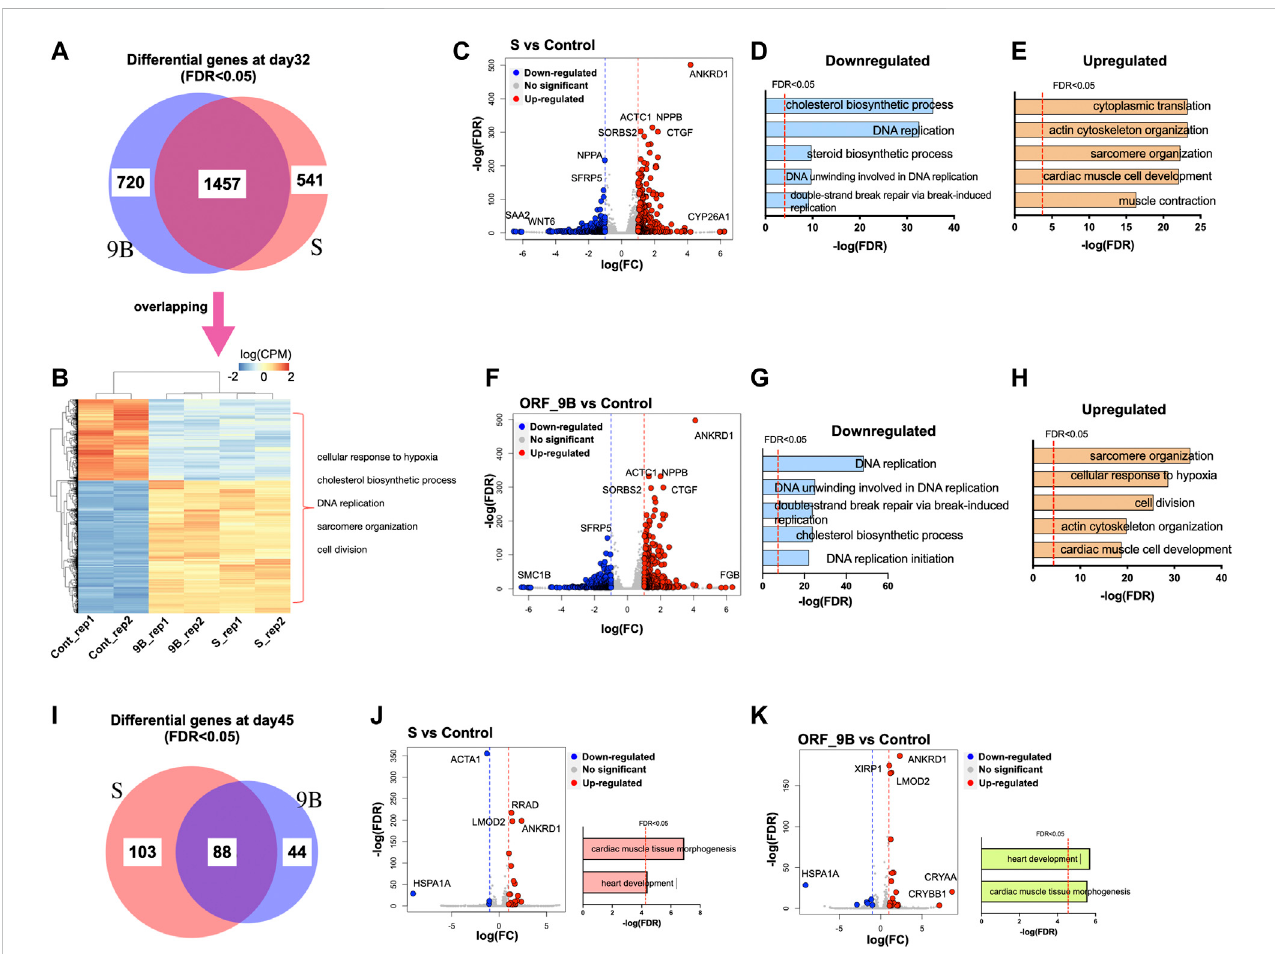
FIGURE 4 Transcriptomic analysis of CMs after overexpression of SARS-CoV-2 subunits. (A) The Venn diagram exhibits the statistically differential genes in CMs afteroverexpressionORF-9BorS(FDR < 0.05)dayday32. (B) TheheatmapexhibitstheexpressionofoverlappingdifferentiallyexpressedgenesintheORF-9B andSgroup,comparedtothatincontrol.Eachgrouphadbiologicalreplicates.TherepresentativeenrichedGOterms(FDR < 0.05)areshownontherightside. (C) ThescatterplotshowsdysregulatedgenesintheSgroupcomparedtothatincontrol(FDR < 0.05withlog[FC]largerthan1).Red,upregulatedgenes; blue, down-regulated genes. (D, E) The top enriched GO terms (FDR < 0.05) of the downregulated genes (D) and the upregulated genes (E) in the S group. (F) The scatter plot shows dysregulated genes in the ORF-9B group compared to that in control (FDR < 0.05 with log[FC] larger than 1). Red, upregulated genes; blue,down-regulatedgenes. (G,H) ThetopenrichedGOterms(FDR < 0.05)ofthedownregulatedgenes (G) andupregulatedgenes (H) intheORF-9Bgroup. (I) The Venn diagram exhibits the statistically differential genes in CMs after overexpression ORF-9B or S (FDR < 0.05) day day45. (J – K) Left, the scatter plot shows dysregulated genes in the S group (J) and ORF-9B group (K) compared to that in control; right, the top enriched GO terms (FDR < 0.05) of the dysregulated genes of each